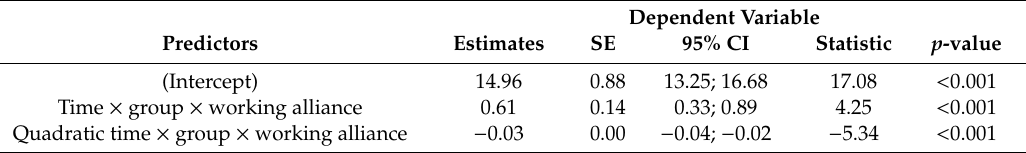
Table 4. Results of the linear mixed model with patient-rated working